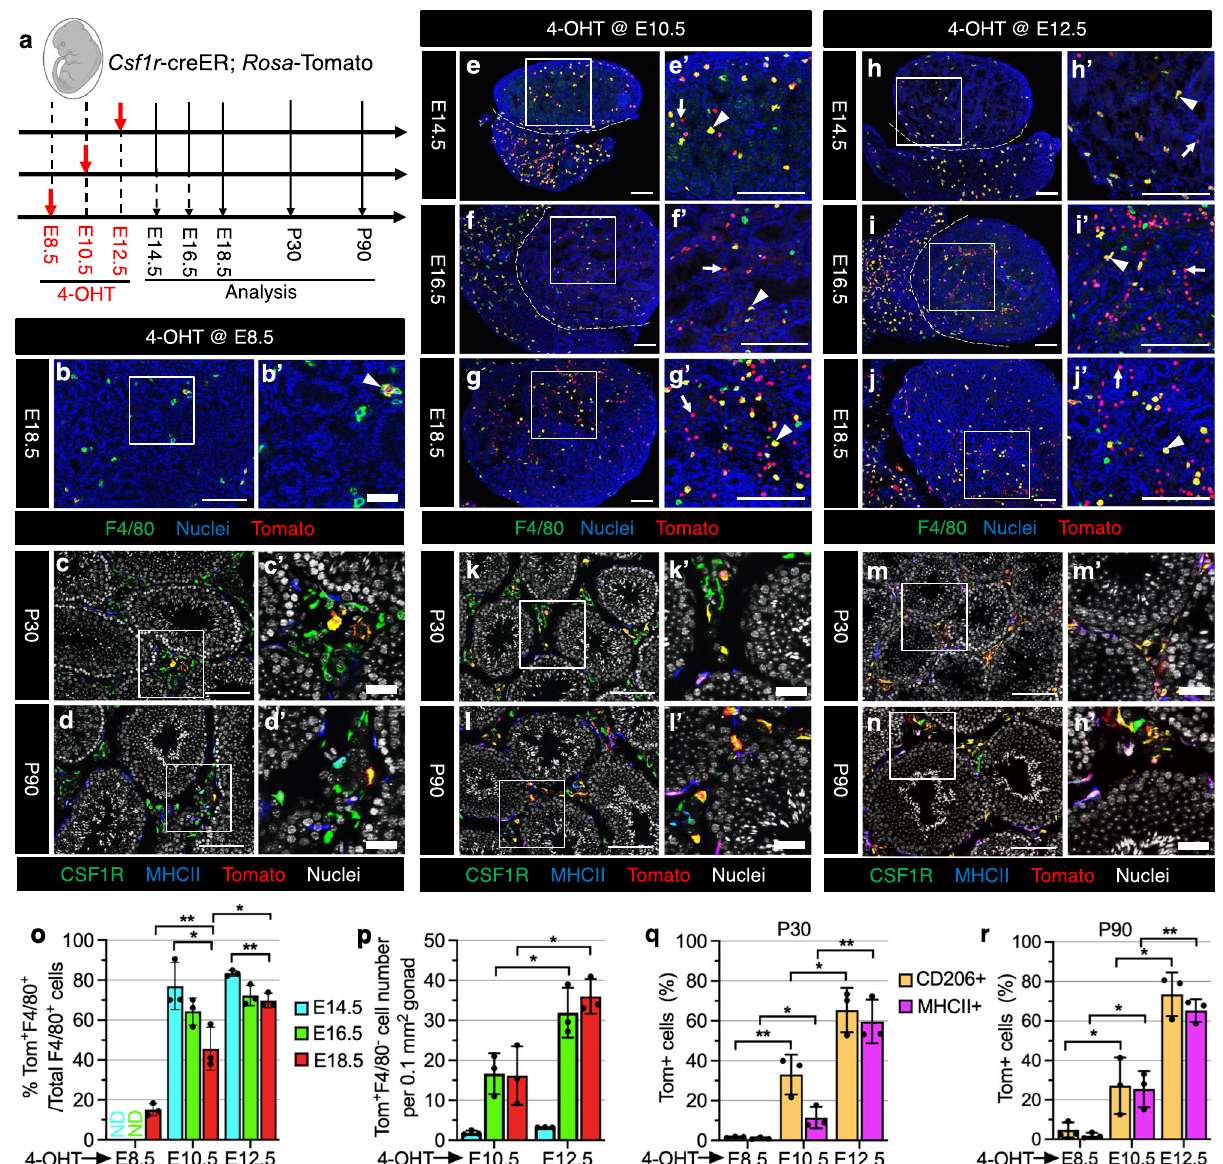
Tomato-expressing F4/80 + macrophages and arrows denote Tomato-expressing F4/80-negative cells. Thin scale bar, 100 μ m; thick scale bar, 25 μ m. o – r Graphs showing quanti fi cation ( n =3 independent gonads) of percent Tomato-expressing F4/80 + macrophagesatE14.5,E16.5,orE18.5( o ),numberofTomato-expressingF4/ 80 − cells per unit area at E14.5, E16.5, or E18.5 ( p ), and percent Tomato-expressing interstitial(CD206 + )andperitubular(MHCII + )macrophagesatP30( q )orP90( r )in Csf1r -creER; Rosa -Tomato testes induced with 4-OHT at various embryonic stages. Data are shown as mean+/ − SD. * P <0.05; ** P <0.01 (two-tailed Student ’ s t test). Exact P values are provided in the Source Data fi